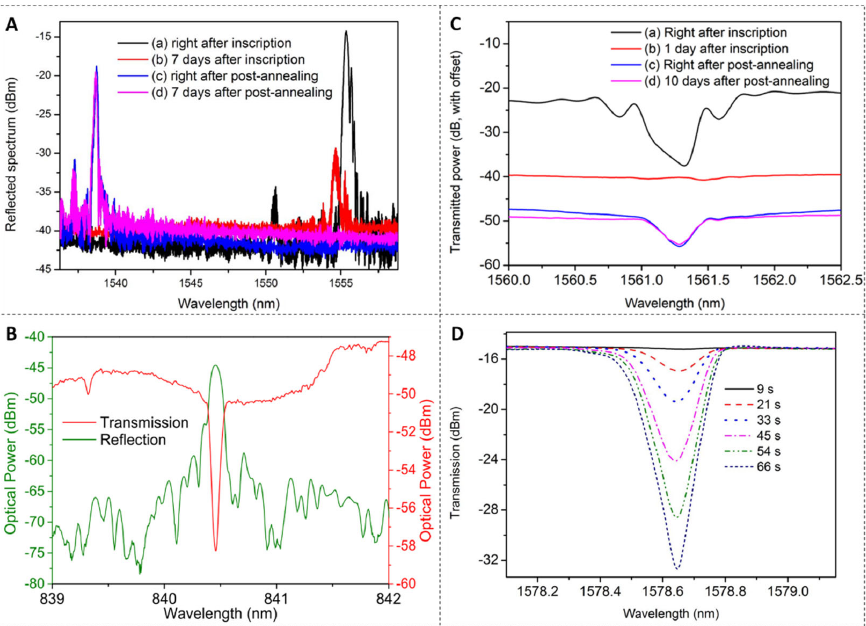
Figure 13. ( A ) Reflected amplitude spectra of FBGs [( a ) just after inscription, ( b ) 7 days after inscription, ( c ) just after post ‐ annealing, and ( d ) 7 days after post ‐ annealing]. Reprinted with permission from [29]. ( B ) Reflection and transmitted amplitude spectra of the inscribed FBG. Reprinted from [43]. ( C ) Transmitted amplitude FBG spectra [( a ) just after inscription, ( b ) 1 day after inscription, ( c ) just after post ‐ annealing for 1 day, and ( d ) 10 days after post ‐ annealing]. Reprinted with permission from [20]. ( D ) The evolution of transmitted amplitude spectra during the FBG inscription process. Reprinted with permission from [49].